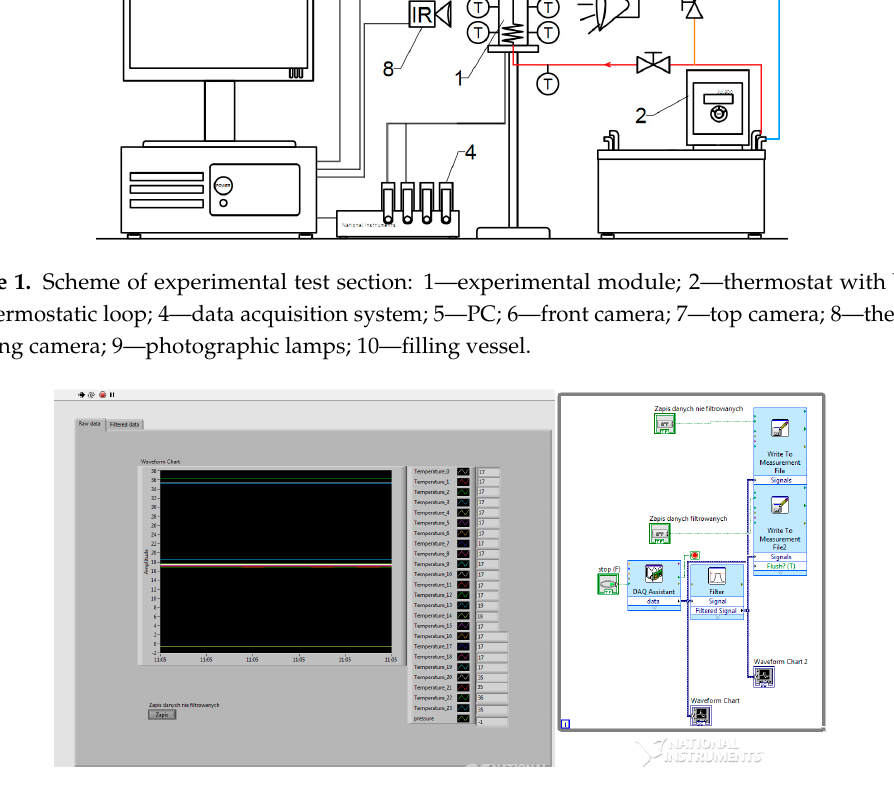
Figure 2. Data acquisition system software: at the left working window, at right block diagram .